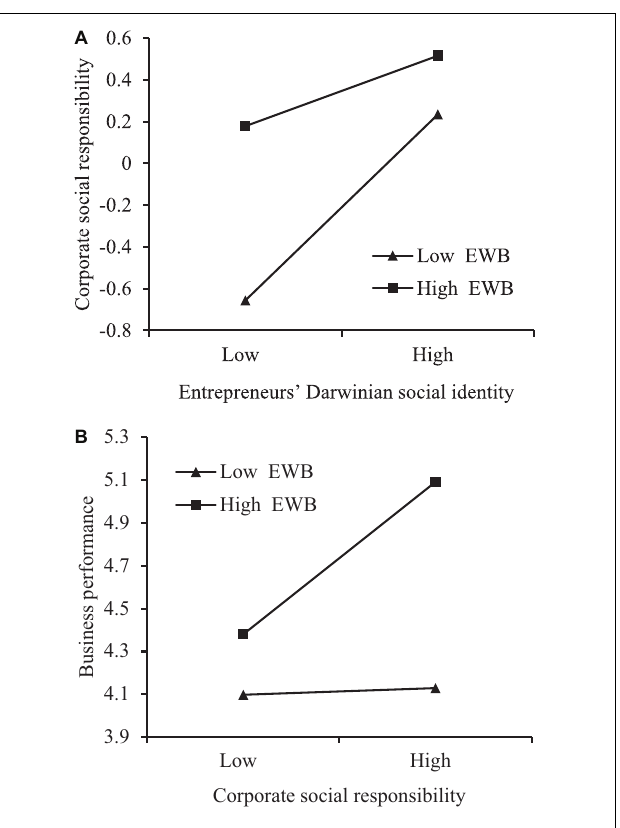
FIGURE 2 | (A) The negative moderating effect of entrepreneurs’ well-being. (B) The positive moderating effect of entrepreneurs’ well-being.